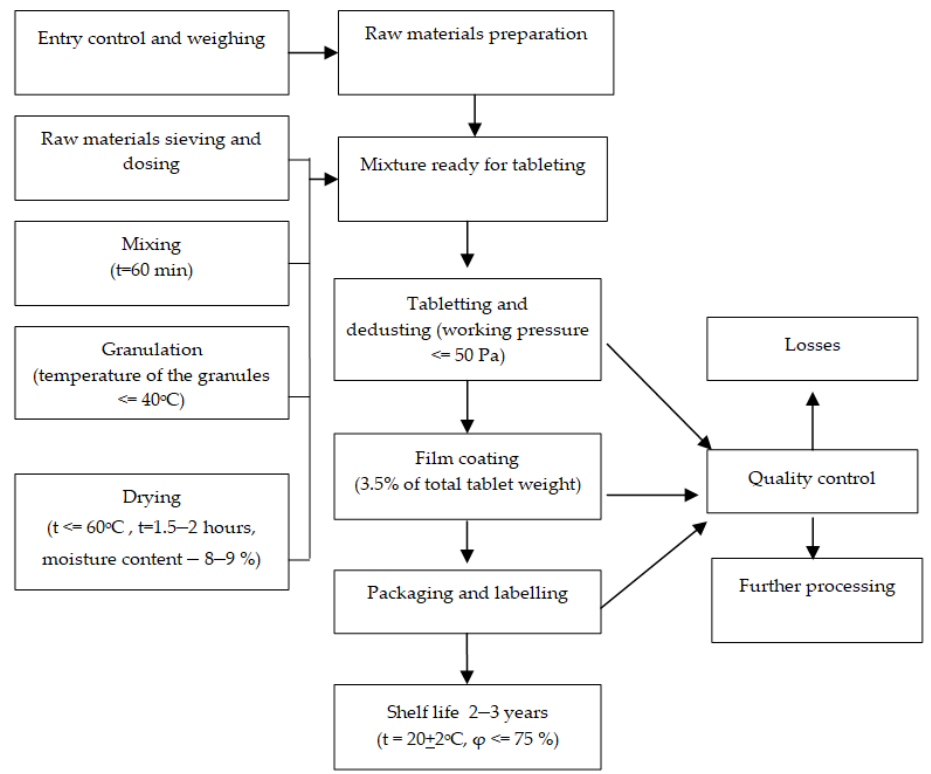
Figure 1. The manufacturing process.